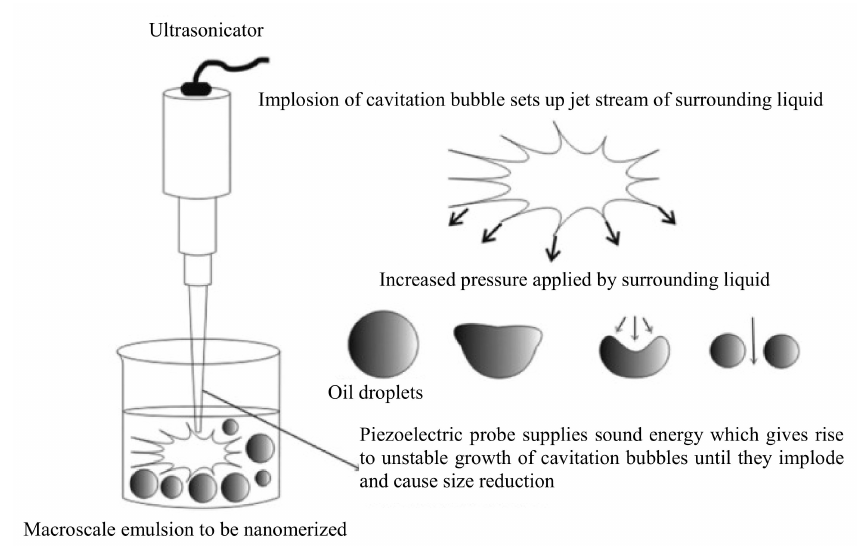
Figure 7. Illustration of sonication e ff ect on the shape and size of the catalyst